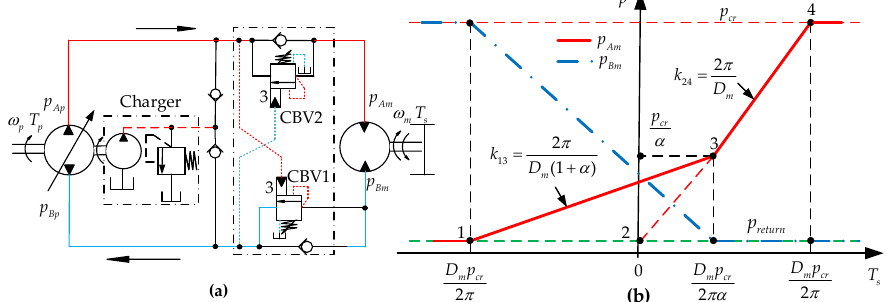
A A Figure 1. ( a ) Cross-section of counterbalance valve (CBV), ( b ) f unction symbol of CBV.